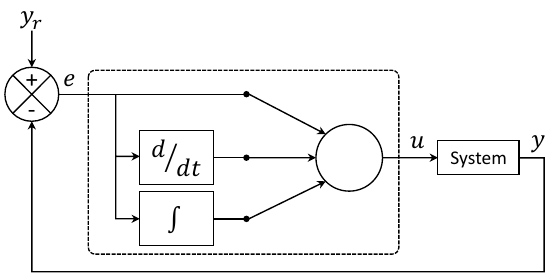
Figure 1. Single neuron PID controller scheme.